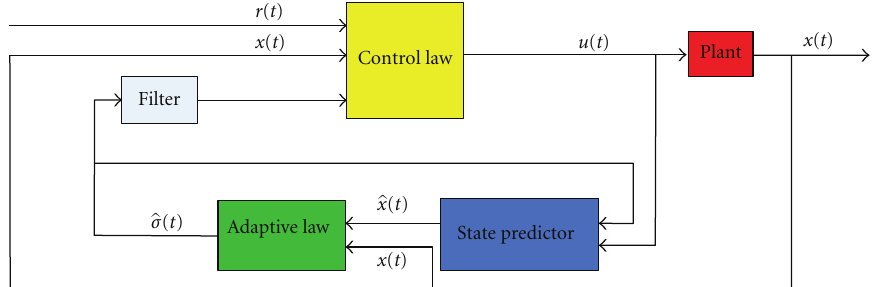
Figure 4: L 1 adaptive controller architecture.